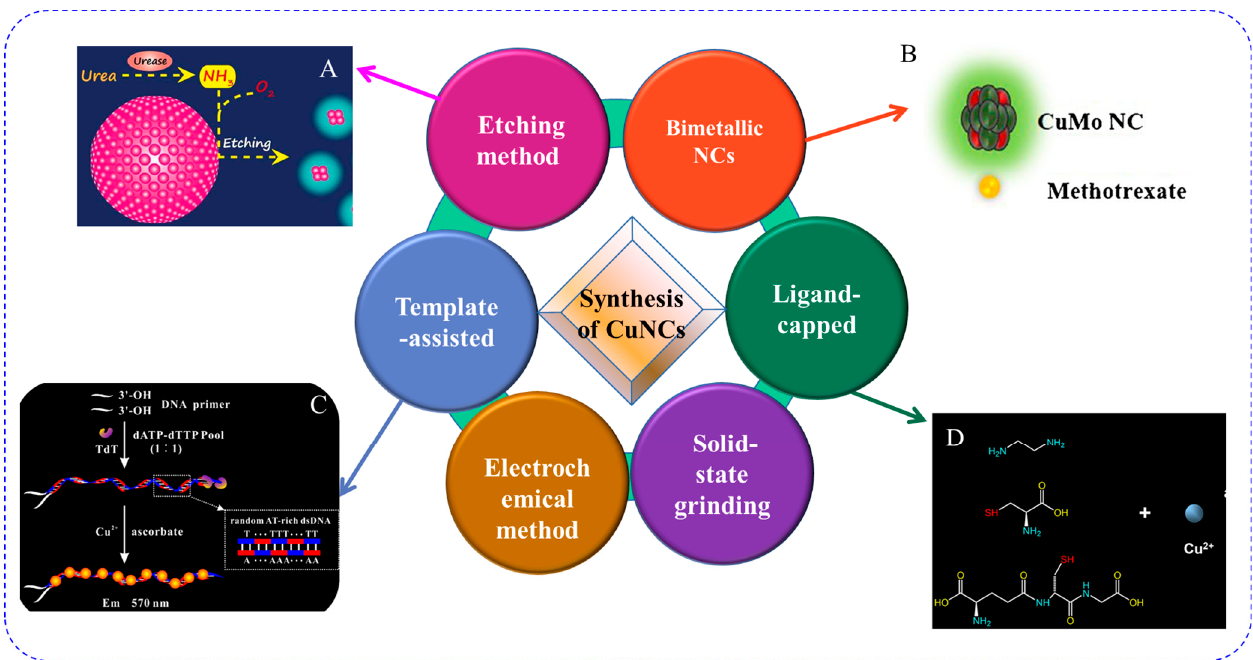
Figure 2. ( A ) Etching method: NH 3 triggered fluorescence generation [38], Copyrights from Royal Society Chemistry, 2018. ( B ) Copper-included bimetallic NCs: Cu/Mo bimetallic NCs [39], Copy- rights from Springer, 2019. ( C ) Examples of the template-assisted method [40], Copyrights from